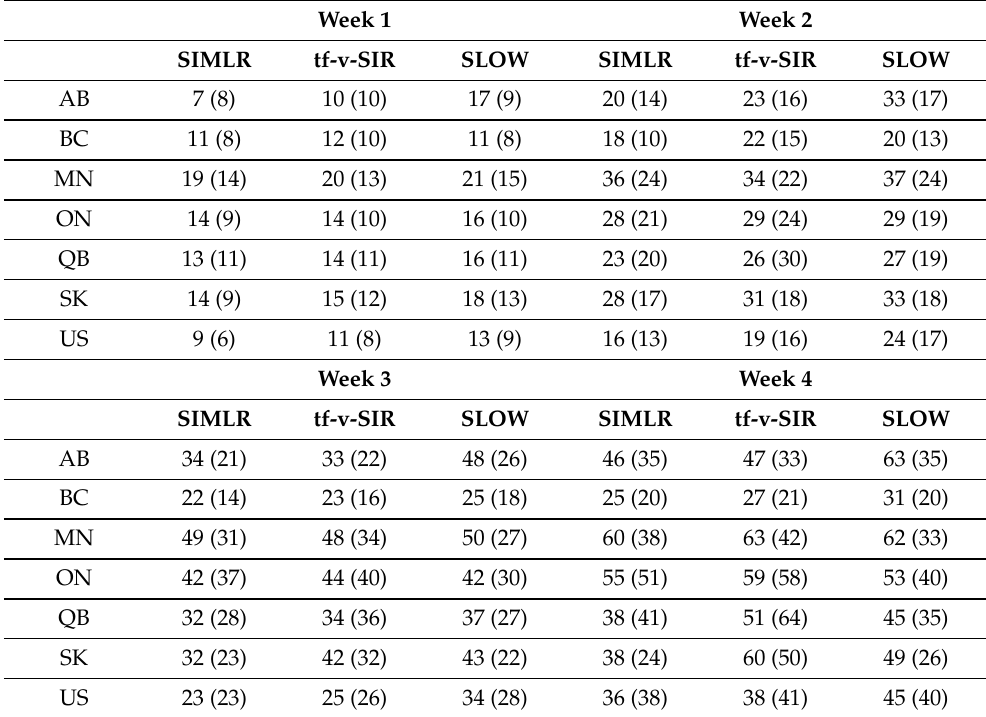
Figure 7. Comparison of SIMLR, SIR model with time-varying parameters, and SLOW in terms of MAE. To make the numbers comparable, the figures each show the US MAE values divided by 100. Table 1. MAPE of the six biggest provinces in Canada and United States as a country, one- to four-weeks in advance. The number in parenthesis is the standard